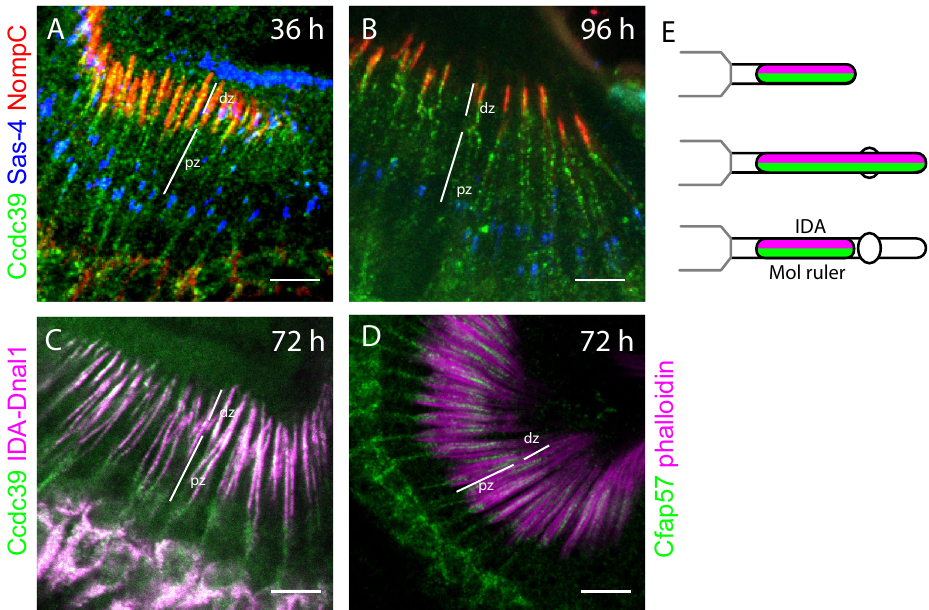
Figure 5. Ccdc39-mVenus localises to the whole cilium in pupal antennae. ( A , B ) Immunofluorescence for Ccdc39-mVenus (green), Sas-4 (blue), NompC (red), with proximal zones (pz) and distal zones (dz) indicated. ( A ) 36-h pupal antenna. ( B ) 96-h pupal antenna. ( C ) 72-h pupal antenna. Colocalisation of Ccdc39-mVenus (green) and IDA-Dnali1-mCherry (magenta). ( D ) Localisation of Cfap57-GFP (green) and phalloidin (magenta). ( E ) Schematic summary of localisation. All scale bars are 5